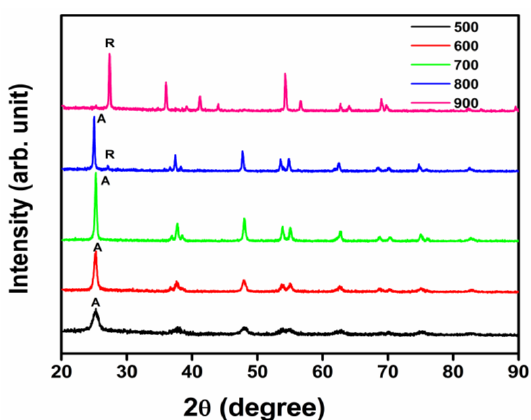
Figure 2. XRD pattern of TiO 2 nanoparticles calcined at different temperatures (R denotes rutile and A denotes anatase phases of TiO 2 nanoparticles).